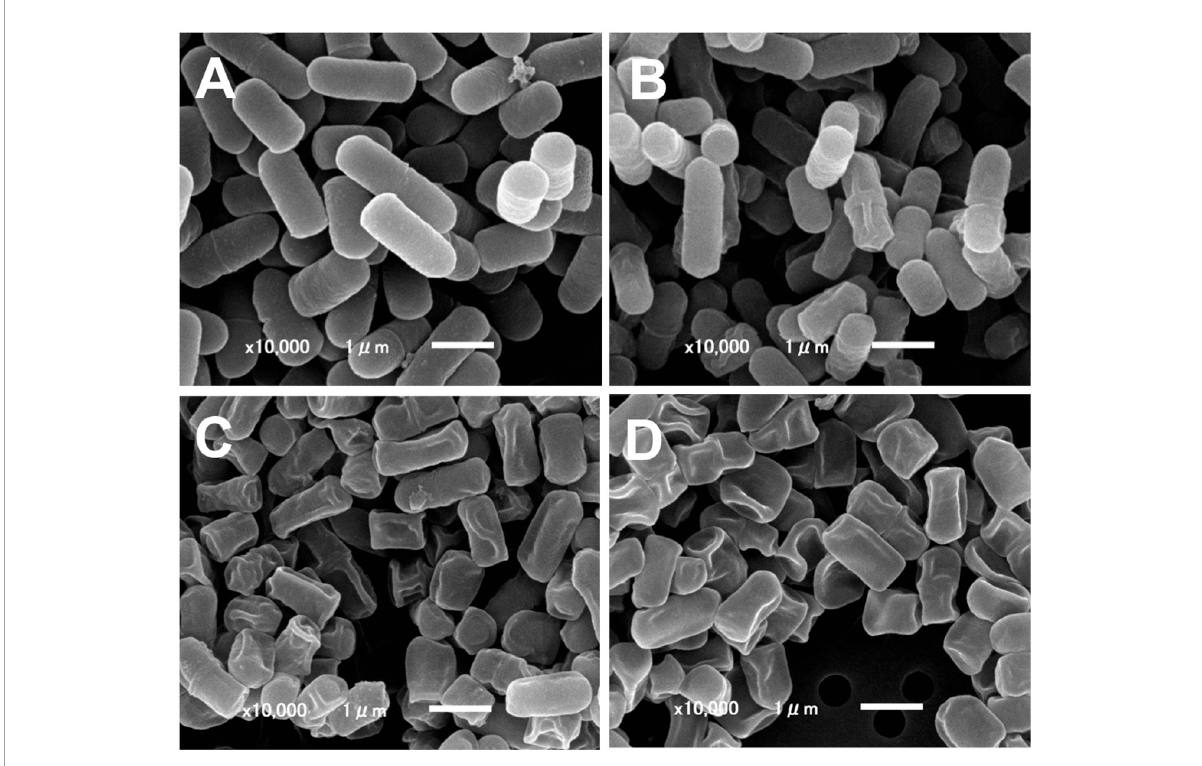
FIGURE1 Scanning electron microscopy of ICWs of L. plantarum TUA 5099L. (A) Heat-killed cells. (B) Intact cell walls. (C) Acid-treated ICWs. (D) Base-treated